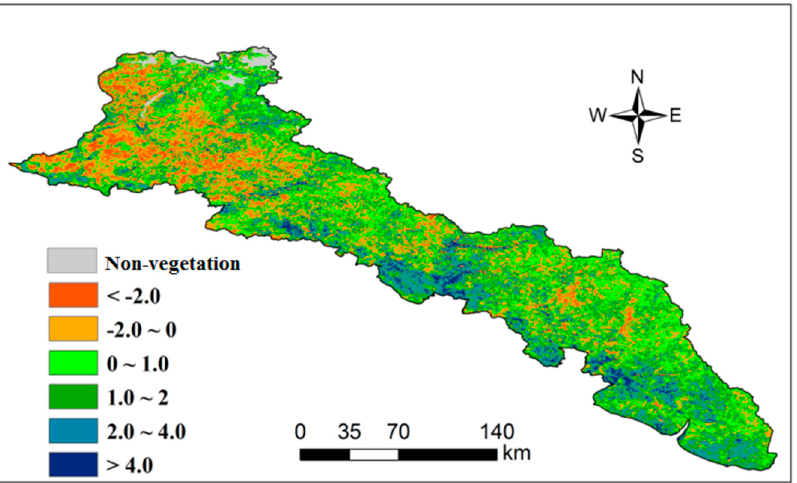
Figure 6. Variation rate of GPP in the Altay Mountains.